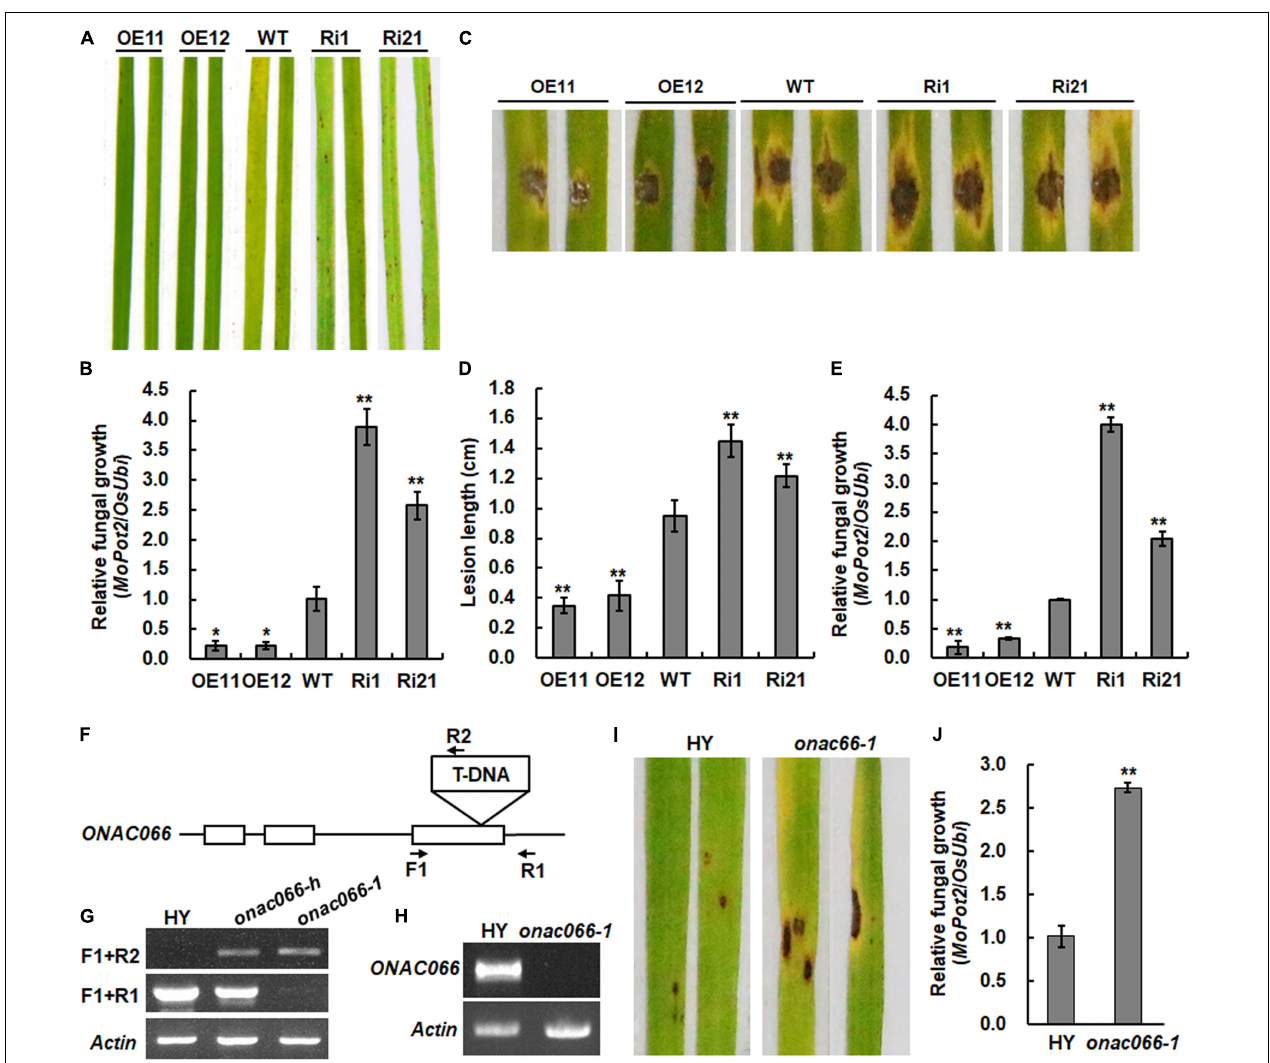
FIGURE 1 | ONAC066 positively regulates rice resistance against Magnaporthe oryzae . (A,B) Representative disease phenotype (A) and relative fungal growth (B) in leaves of ONAC066 -OE and ONAC066 -Ri plants. (C–E) Representative disease phenotype (C) , lesion length (D) , and relative fungal growth (E) in detached leaves of ONAC066 -OE and ONAC066 -Ri plants. (F) Gene structure of ONAC066 and location of T-DNA. Open boxes indicate the exons while lines indicate introns. Primers used for genotyping are indicated. (G) Genotyping of onac066-1 mutant by genome DNA PCR. F1 and R1 were used as gene-specific primers and R2/2707RB was a T-DNA-specific primer. onac066-h and onac066-1 stand for heterozygous and homozygous rice plants, respectively. (H) Detection of ONAC066 transcript in onac066-1 mutant plants. (I,J) Representative disease phenotype (I) and relative fungal growth (J) in leaves of onac066 plants. 4-week-old plants of different genotypes were inoculated by foliar spraying of spore suspension of M. oryzae (A,I) or detached leaves from 4-week-old plants were inoculated by dropping 5 µ l spore suspension of M. oryzae (C) . Photographs and leaf samples were taken at 5 days post inoculation. Relative fungal growth was quantified by genomic qRT-RCR analyzing of the M. oryzae MoPot2 and rice OsUbi genes and shown as ratios of MoPot2 / OsUbi . Experiments were repeated at least three times with similar results, and results from one representative experiment are shown in panels (A , C,I) . Data presented in panels (B,D,E,J) are the means ± SD from three independent experiments and **/* indicated significant difference at p < 0.01 and p < 0.05 levels, respectively, by Student’s t -test, in comparison to